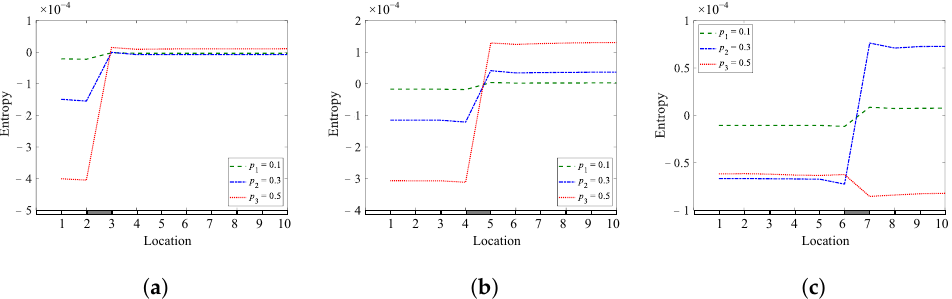
Figure 21. Entropy of a simply supported beam for different crack depths and locations: ( a ) q 1 = 0.25; ( b ) q 2 = 0.45; ( c ) q 3 = 0.65.